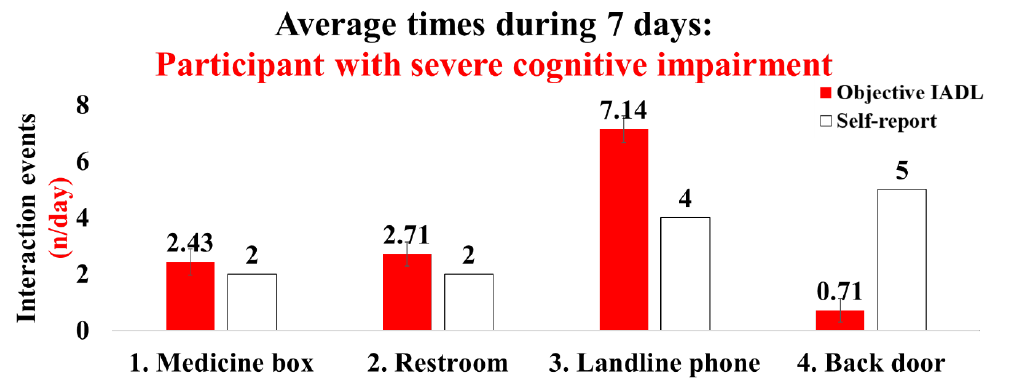
Figure 9. Results of the interaction times for IADLs in the patient with severe cognitive impairment: the objective IADL values provide mean and standard errors for 7 days.